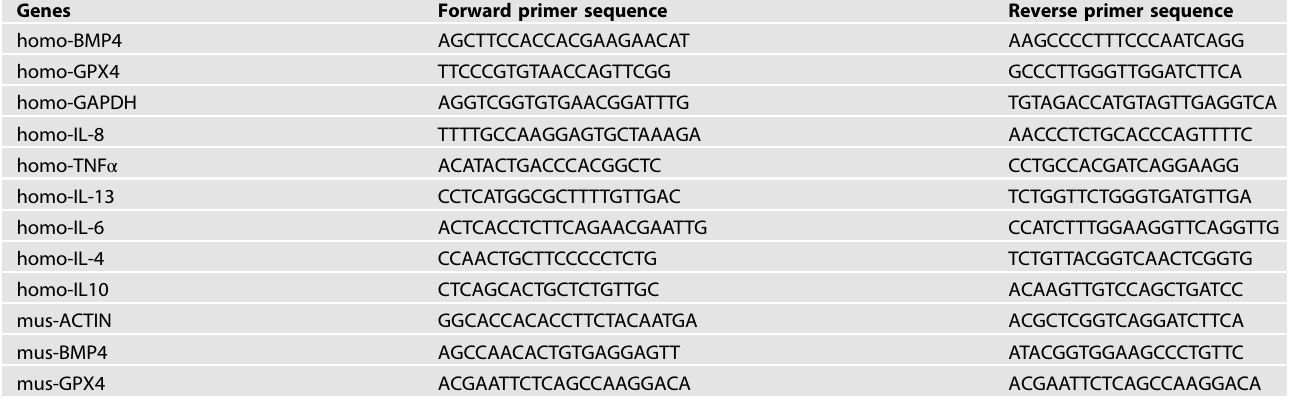
Table 2. Primer sequences for